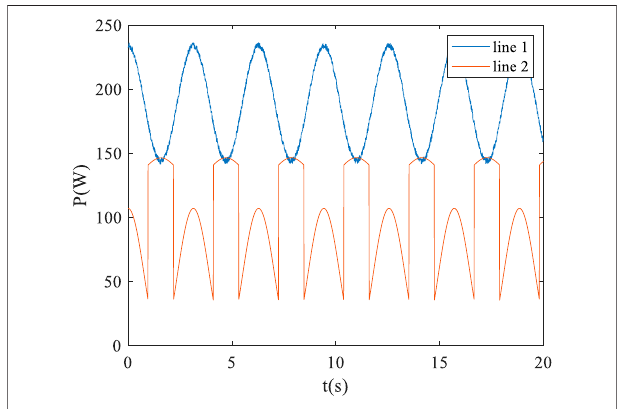
FIGURE 15 | Simulated cure of the maximum power control strategy based on power trajectory